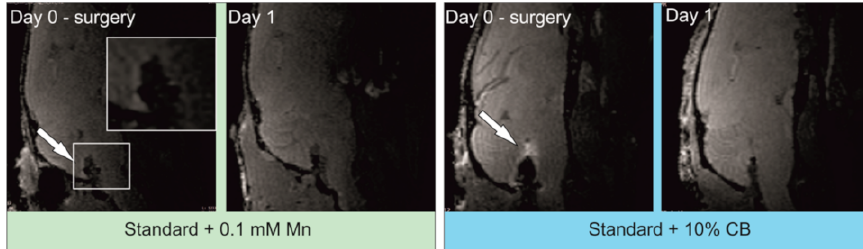
Figure 9. T1-weighted MRI of alginate hydrogels supplemented with 0.1 mM Mn 2+ or compact manganese alginate particles directly and 24 h after intrathecal transplantation. Arrow indicates a hyperintense signal that corresponds to hydrogel localization. A cropped image of the selected region of interest presents the magnification of the intrathecal area with a hyperintense signal. No signal can be observed after 24